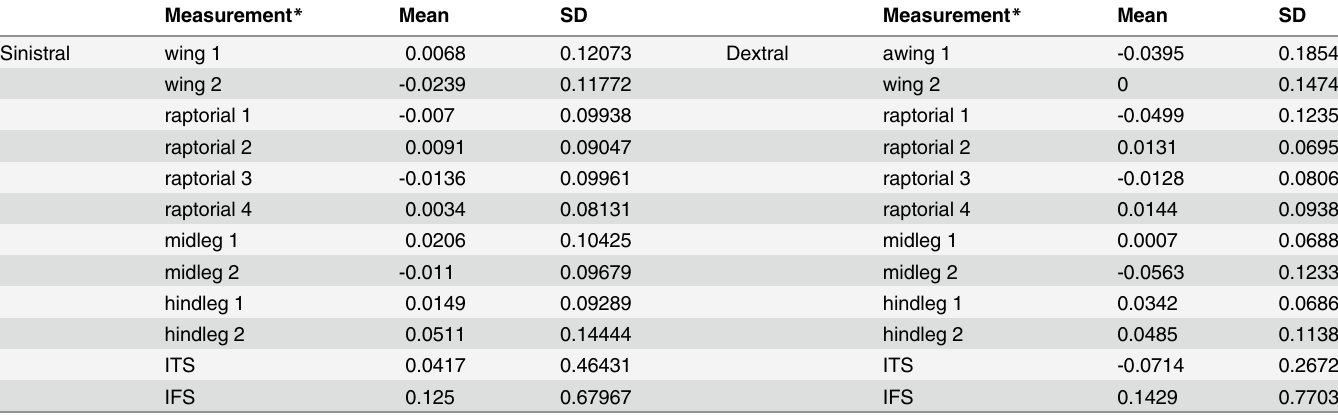
Table 2. Summary of means and standard deviations (SD) of the degree of asymmetry for 12 paired morphological measurements for males of si- nistral and dextral genital orientation (refer to methods for calculation of degree of asymmetry). Measurement *